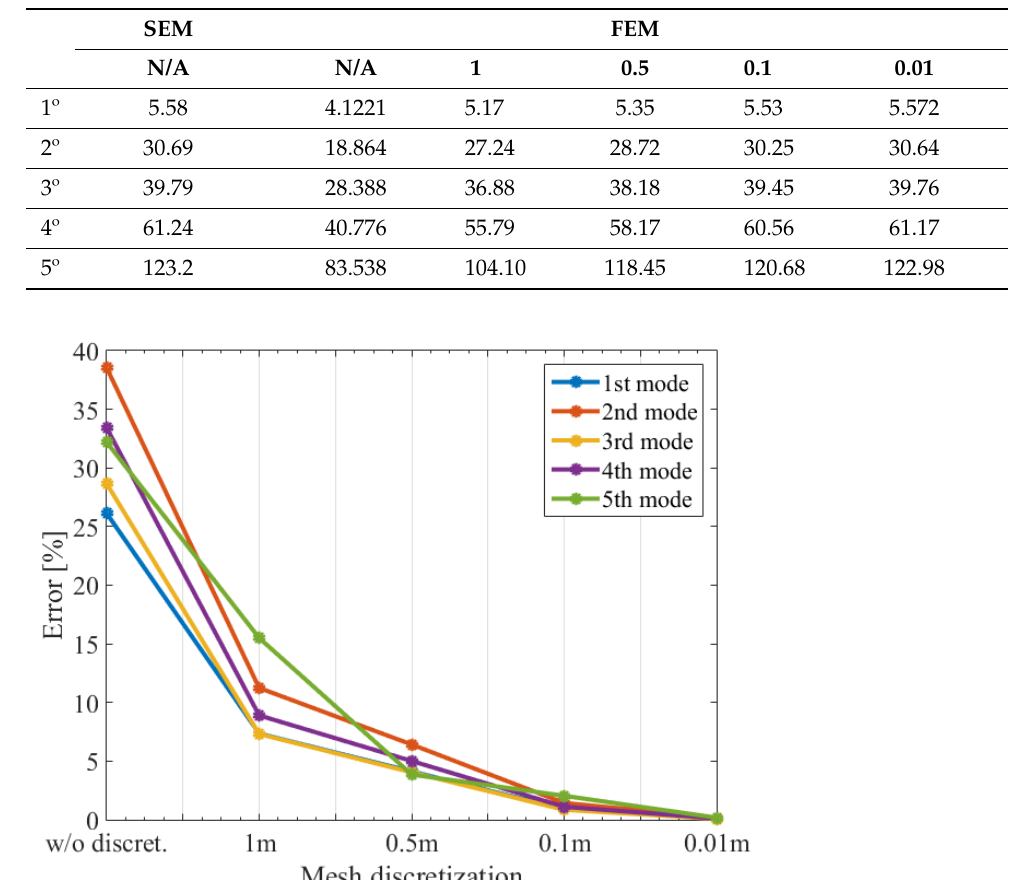
Figure 9. Tower mesh convergence percentage error.